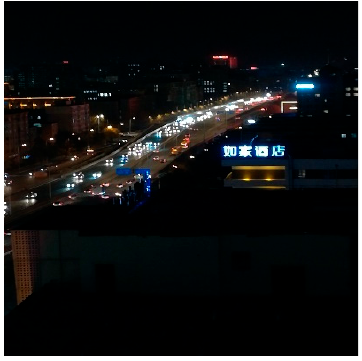
Figure 2. Data acquisition scenario.